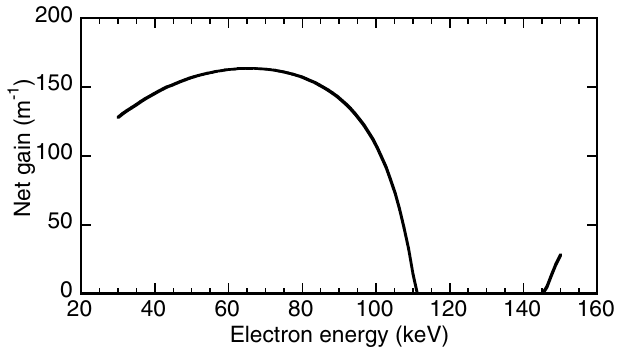
FIG. 4. Net gain calculated for the Dartmouth